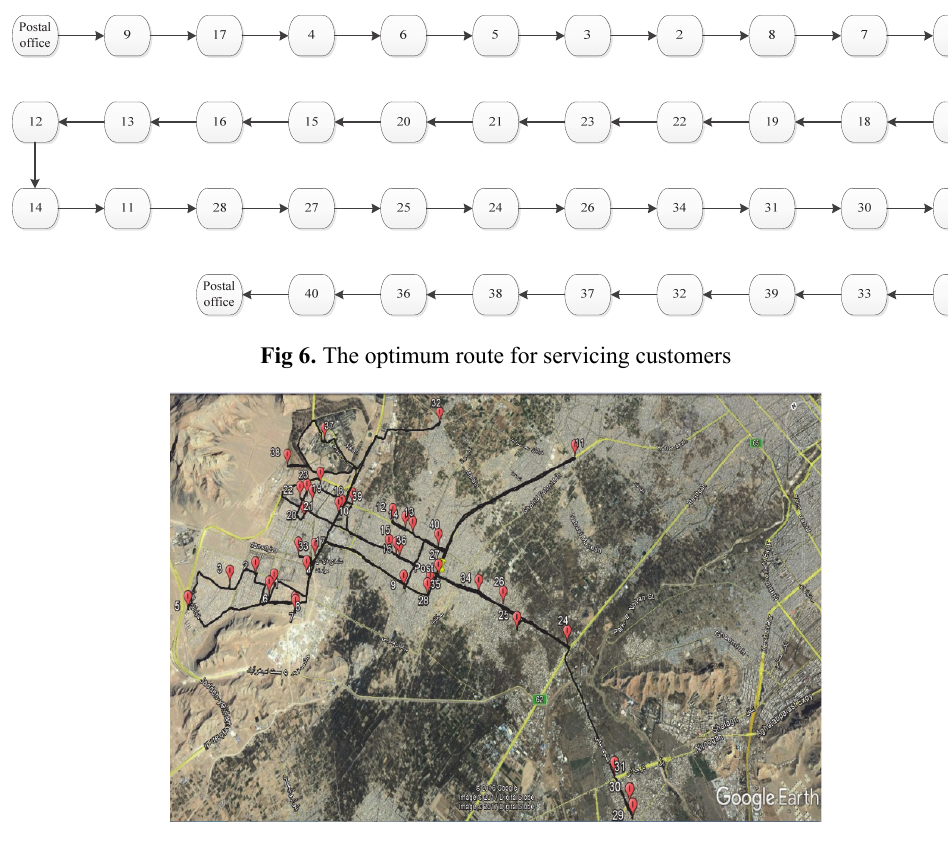
Fig 7. Geographical representation of the optimum route for servicing